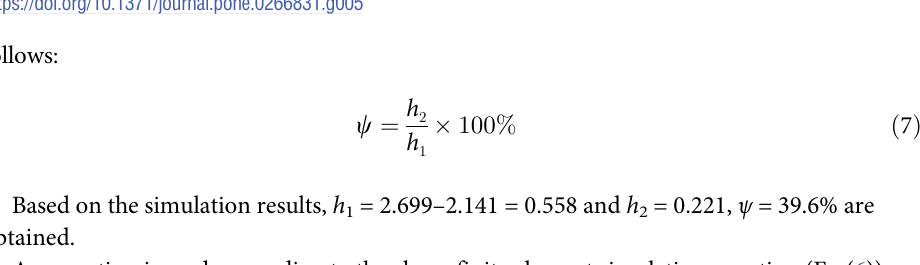
Fig 5. Curve of the impact energy. CKE, coal kinetic energy. MTE, energy of the middle trough.